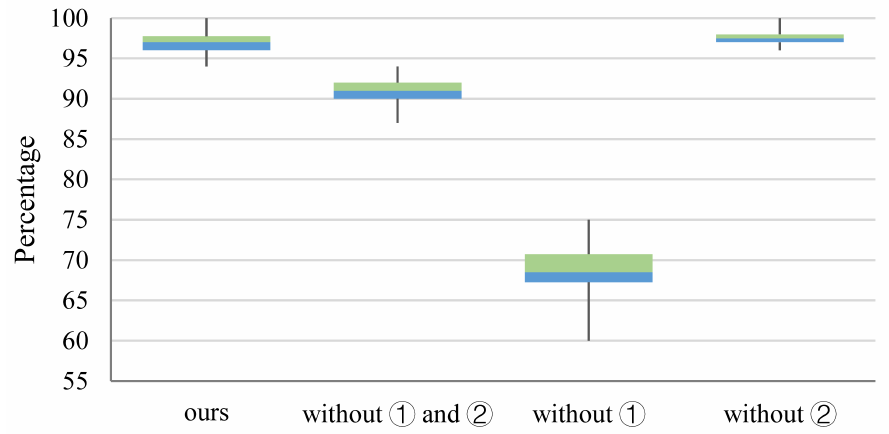
Figure 4. Statistical distribution of success rate of information extraction success rate.